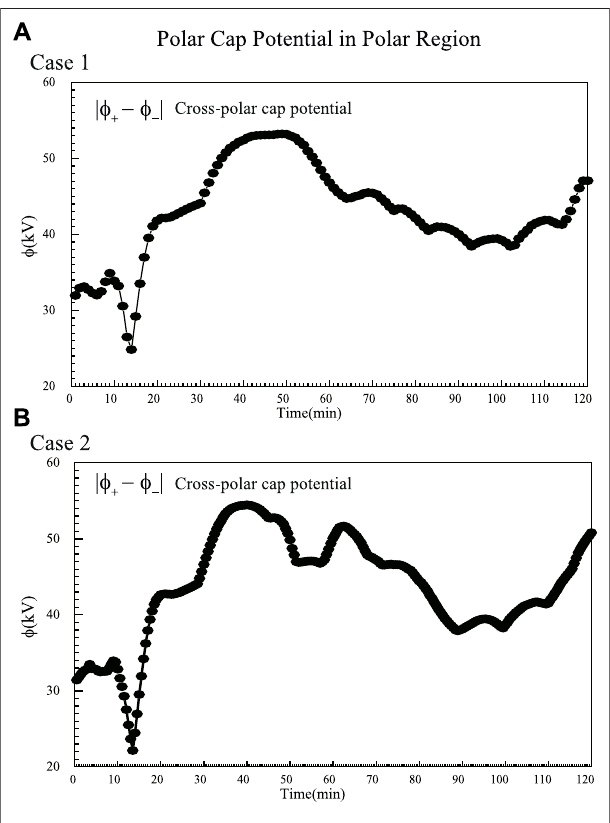
FIGURE6| Thesimulationresultsoftheevolutionovertimeofthecross- polar cap potential mapped onto the polar region for 1 min time resolution in Case 1 (A) and for 30 s time resolution in Case 2 (B)